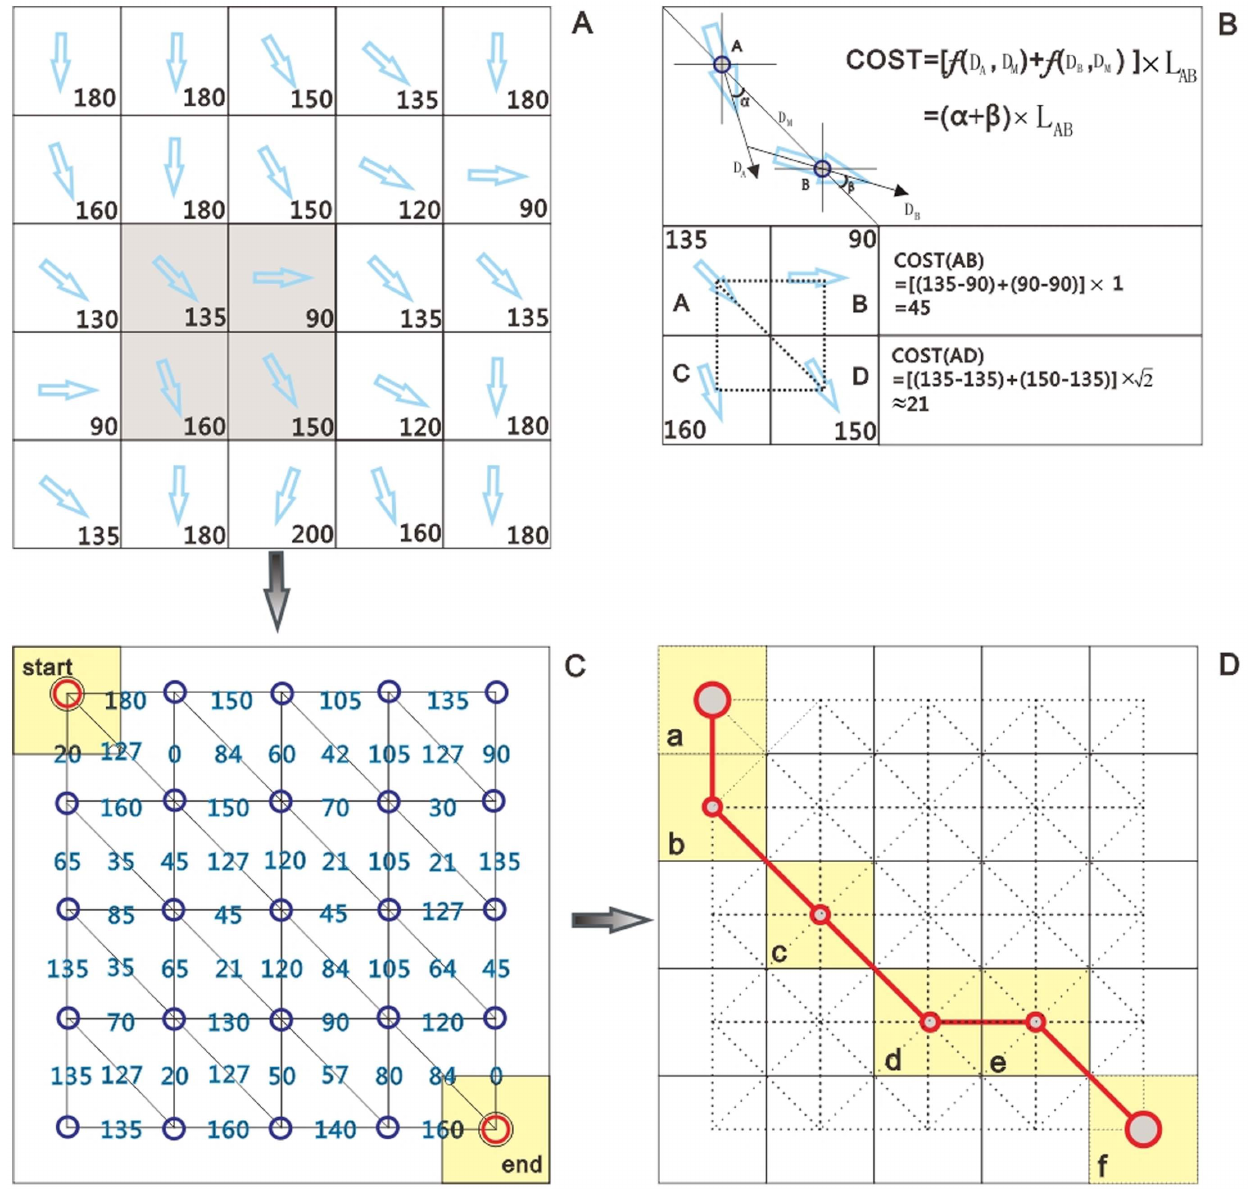
Figure 3. Steps for calculating SWPDs using a wind-field. (A) Grid-based representation of a wind-field. (B) Computing the cost associated with the edge between adjacent cells. (C) Reforming a grid-based wind-field into a graph. (D) SWPD calculated between starting point A and ending point F.